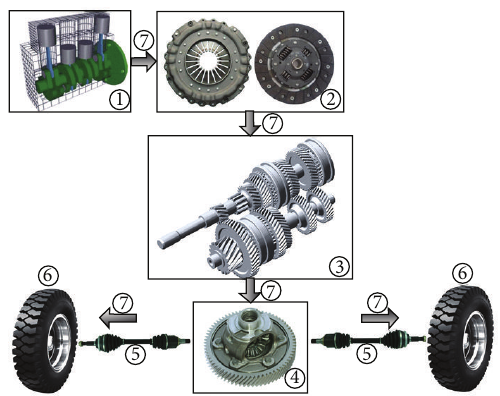
Figure 1: RWD vehicle powertrain system: A four-cylinder and four-stroke engine, B clutch damper, C manual transmission, D differential mechanism, E half axle, F wheel, and G power flow.